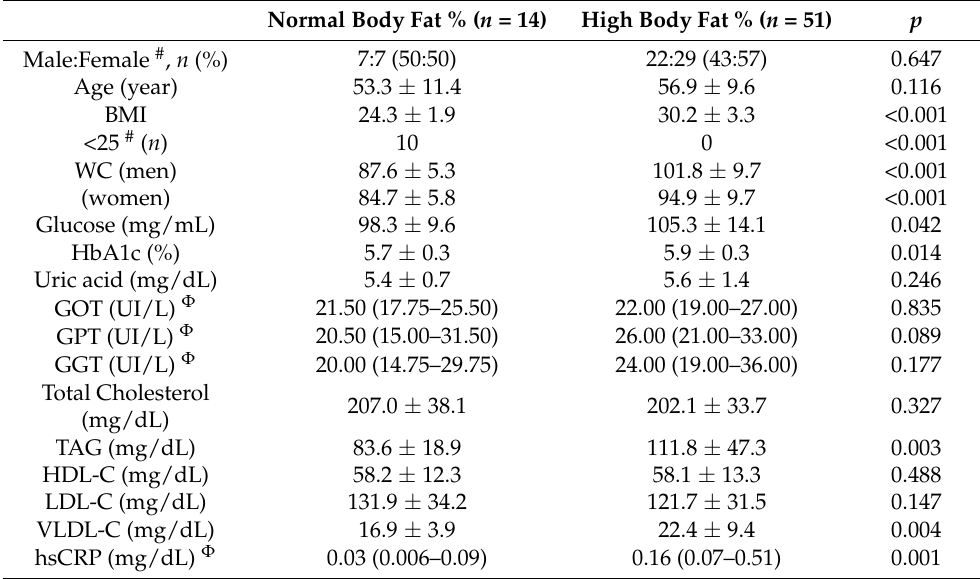
Table 2. Basal characteristics of the participants with prediabetes according to their body fat